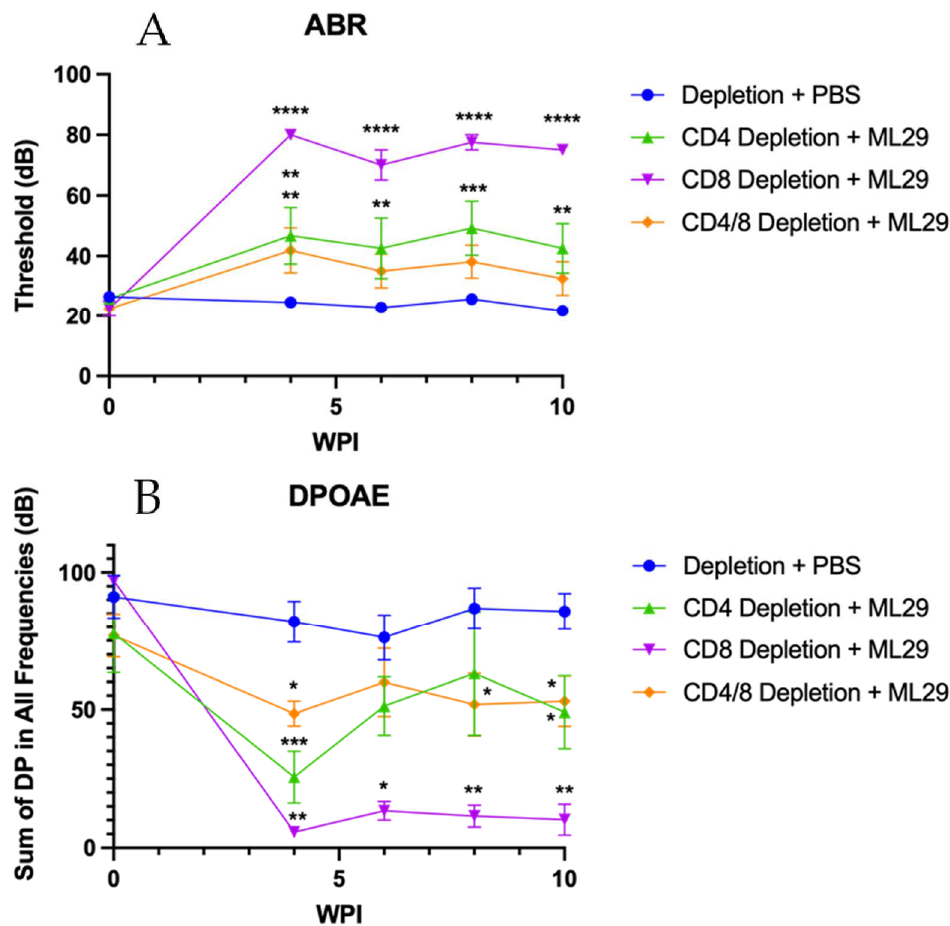
Figure 6. ML29-inoculated mice appear to develop hearing loss through a T cell-independent mechanism. ABR ( A ) and DPOAE ( B ) were performed on the survivors of individual CD4 or CD8 depletions. n = 14 Depletion + PBS; n = 8 CD4/8 Depletion + ML29; n = 6 CD4 Depletion + ML29; n = 2 CD8 Depletion + ML29. Data presented as mean ± SEM. * p < 0.05, ** p < 0.01, *** p < 0.001, **** p < 0.0001.